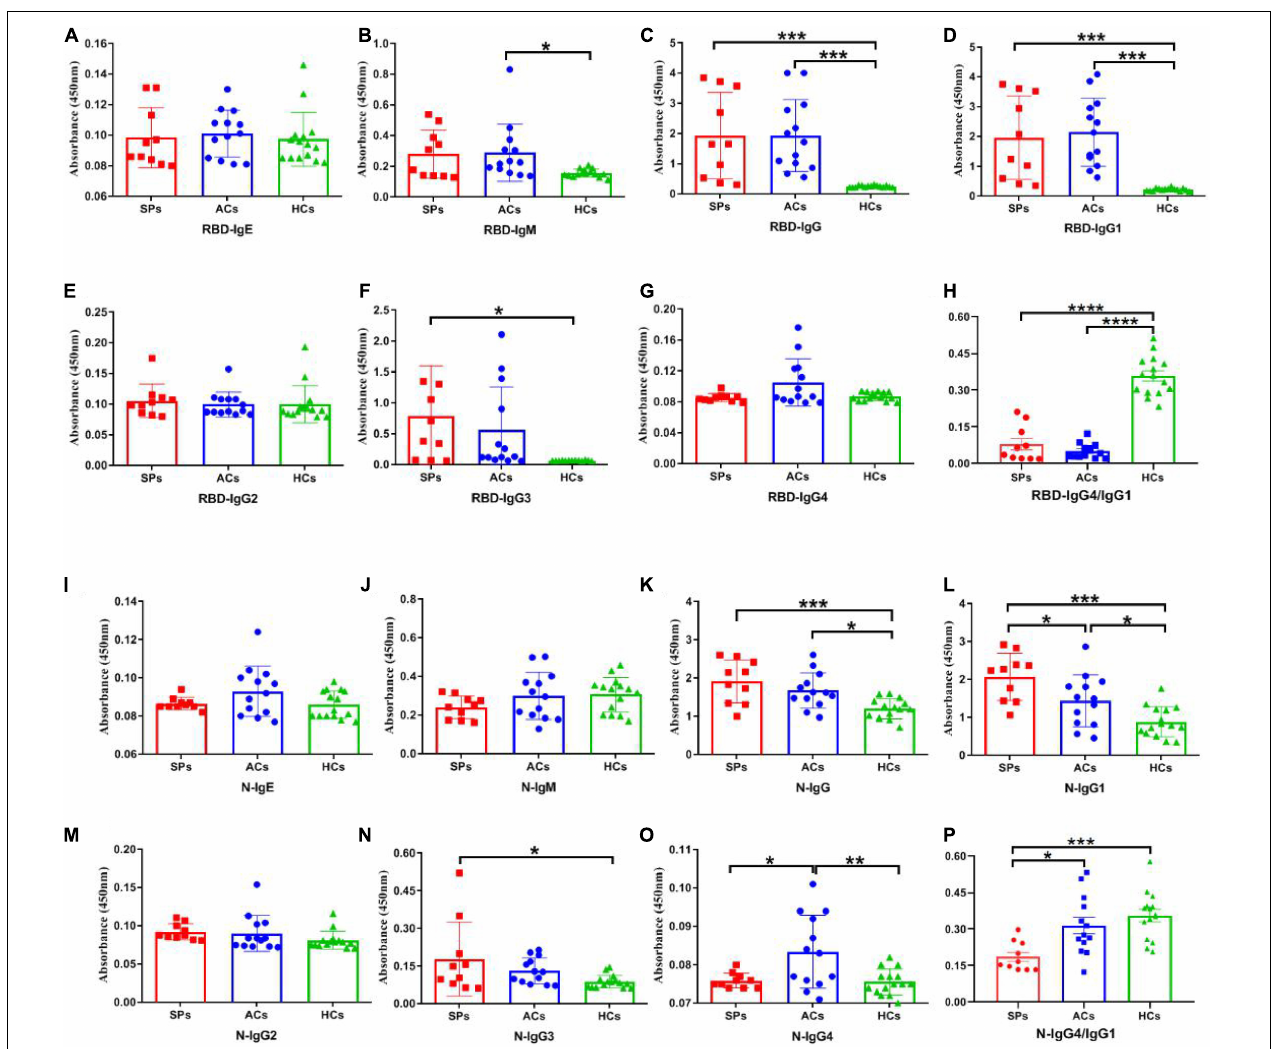
FIGURE 4 | SARS-CoV-2 RBD and N-specific binding antibodies in SPs, ACs, and HCs. IgE, IgM, IgG, IgG1, IgG2, IgG3, and IgG4 antibody RBD protein of SARS-CoV-2 were detected in sera (A–G) . IgE, IgM, IgG, IgG1, IgG2, IgG3, and IgG4 antibody against N protein of SARS-CoV-2 were detected in sera (I–O) . The ratio of IgG4/IgG1 against RBD and N protein of SARS-CoV-2 in SPs and ACs were summarized (H,P) . Data are presented as means ± SEM. * P < 0.05, ** P < 0.01,*** P < 0.001, **** P <